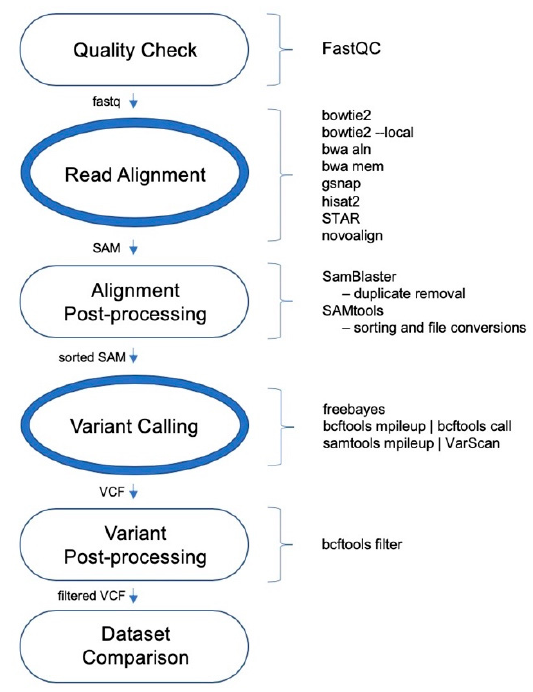
Figure 1. Schematic of the variant calling pipeline used.